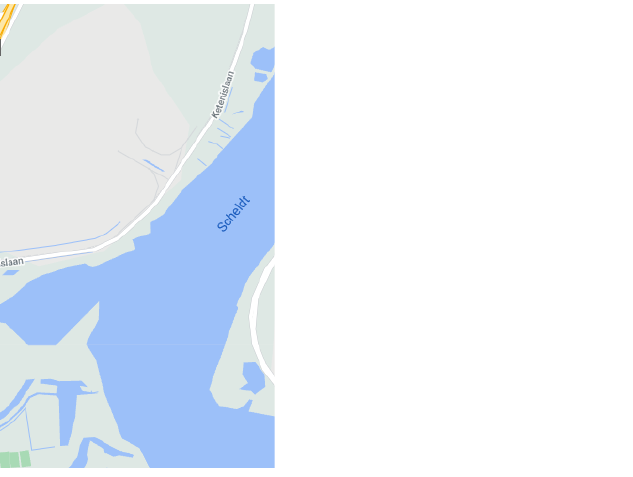
Figure 1. The Beveren tunnel in Antwerp, Belgium. The vehicle travels from point R2 with a speed of 90 km/h toward the end of the tunnel, marked with a teardrop-shaped location symbol. ©2021 Google.